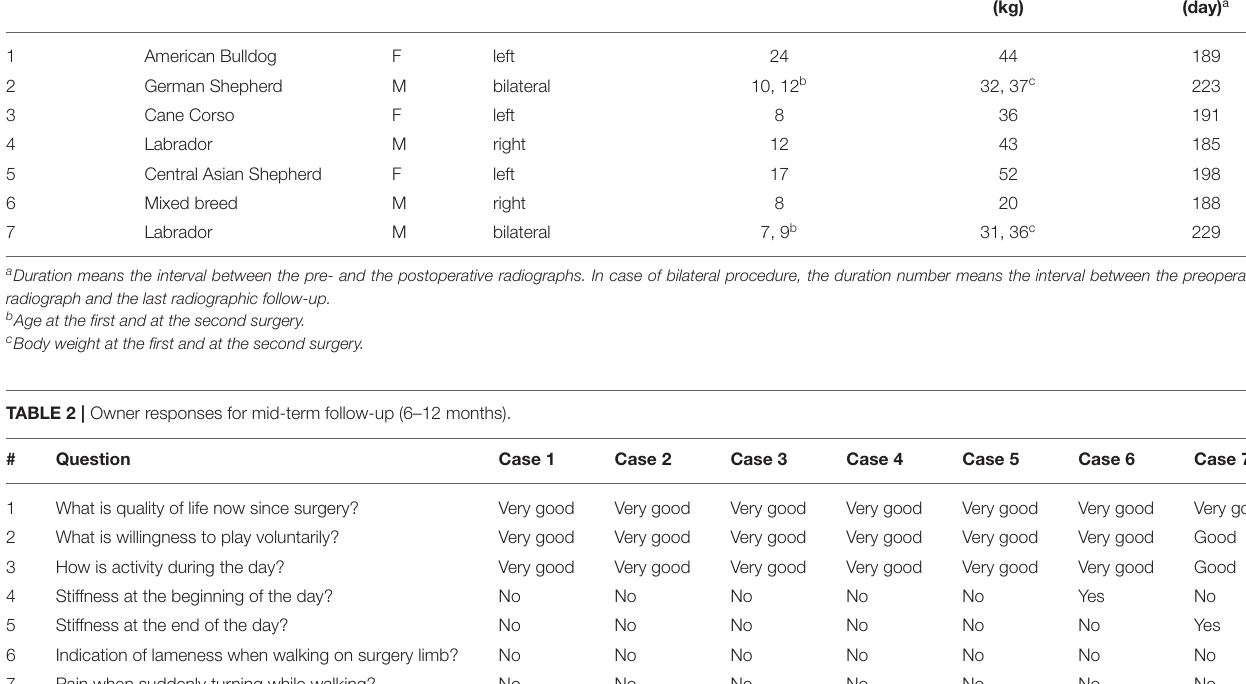
Follow-up (kg) (day)